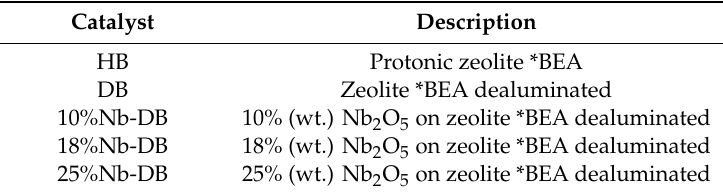
Table 1. Nomenclature and description of the